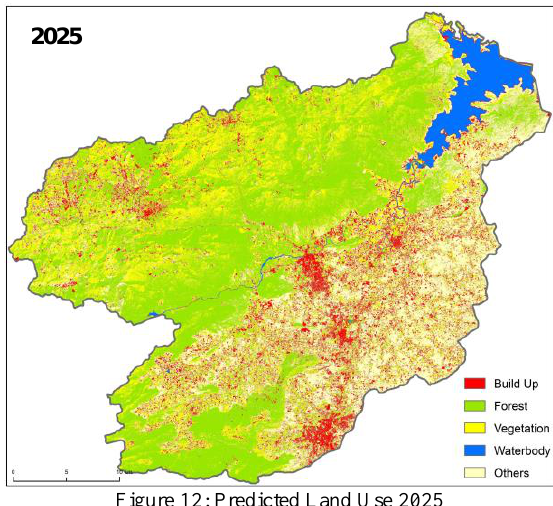
Figure 12: Predicted Land Use 2025